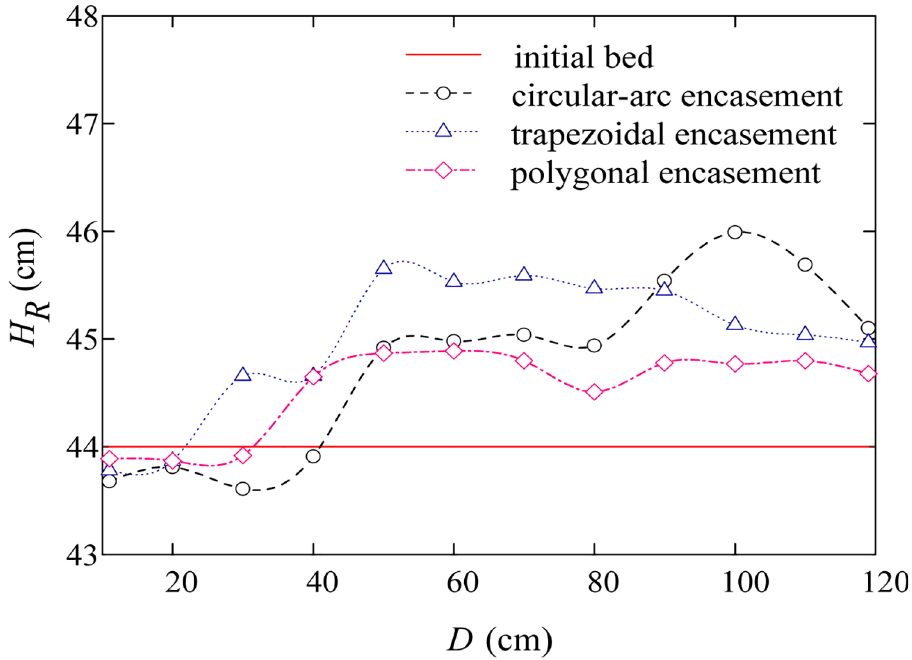
Fig 9. Transversal deposition profile of CS6 for a 50-year flood event.